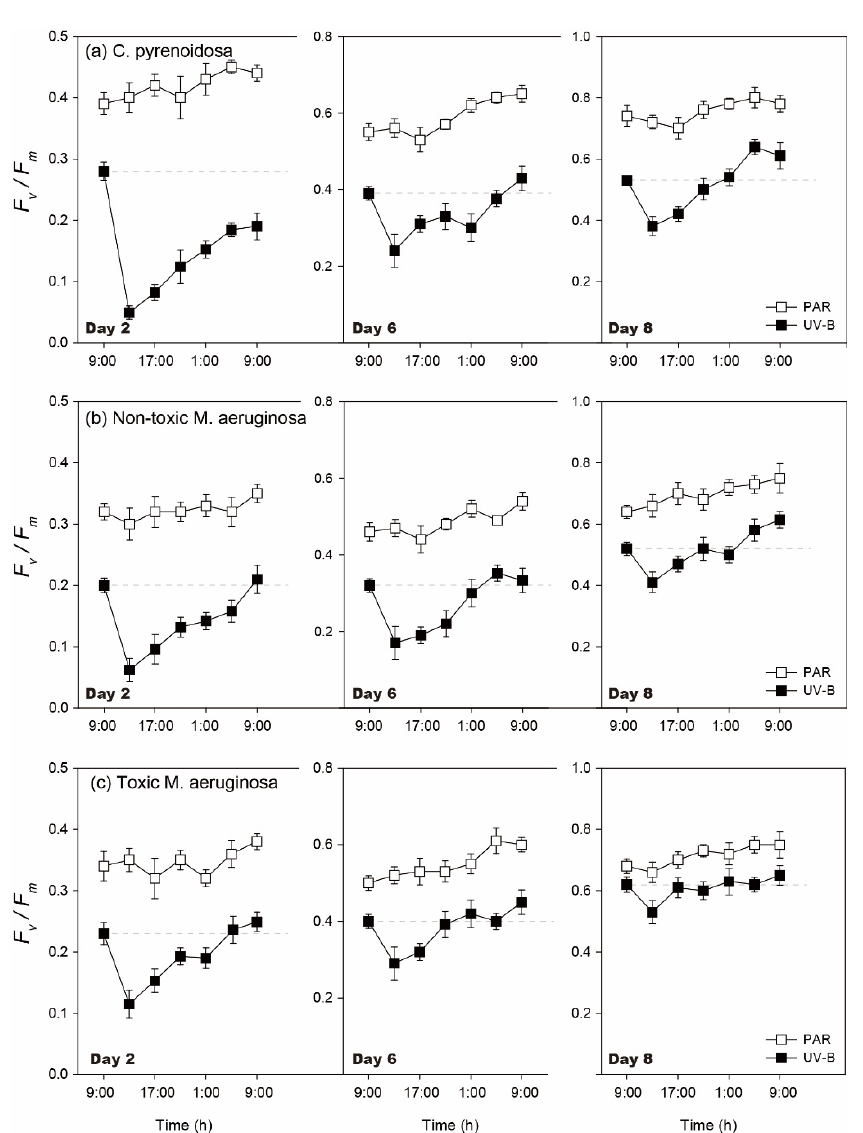
Figure 8. Diurnal changes of F v /F m of three species in the PAR and UV ‐ B treatments under nutrient enrichment conditions on Day 2, Day 6, and Day 8.